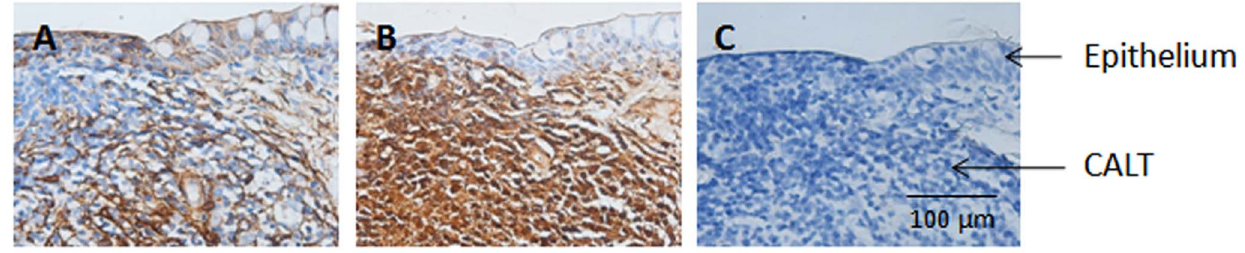
Figure 3. MMP-2 and MMP-9 expression in conjunctival associated lymphoid tissue (CALT) in the palpebral conjunctiva. Representative light micrographs of a section through CALT showing (A) MMP-2, (B) MMP-9 expression and (C) IgG control, at the time of corneal wound closure.